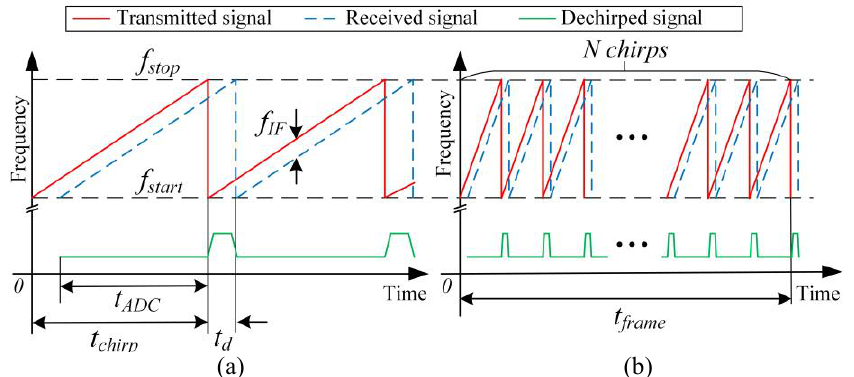
Fig. 1. Sawtooth modulation scheme of FMCW radar: in chirp (a) and frame (b) time